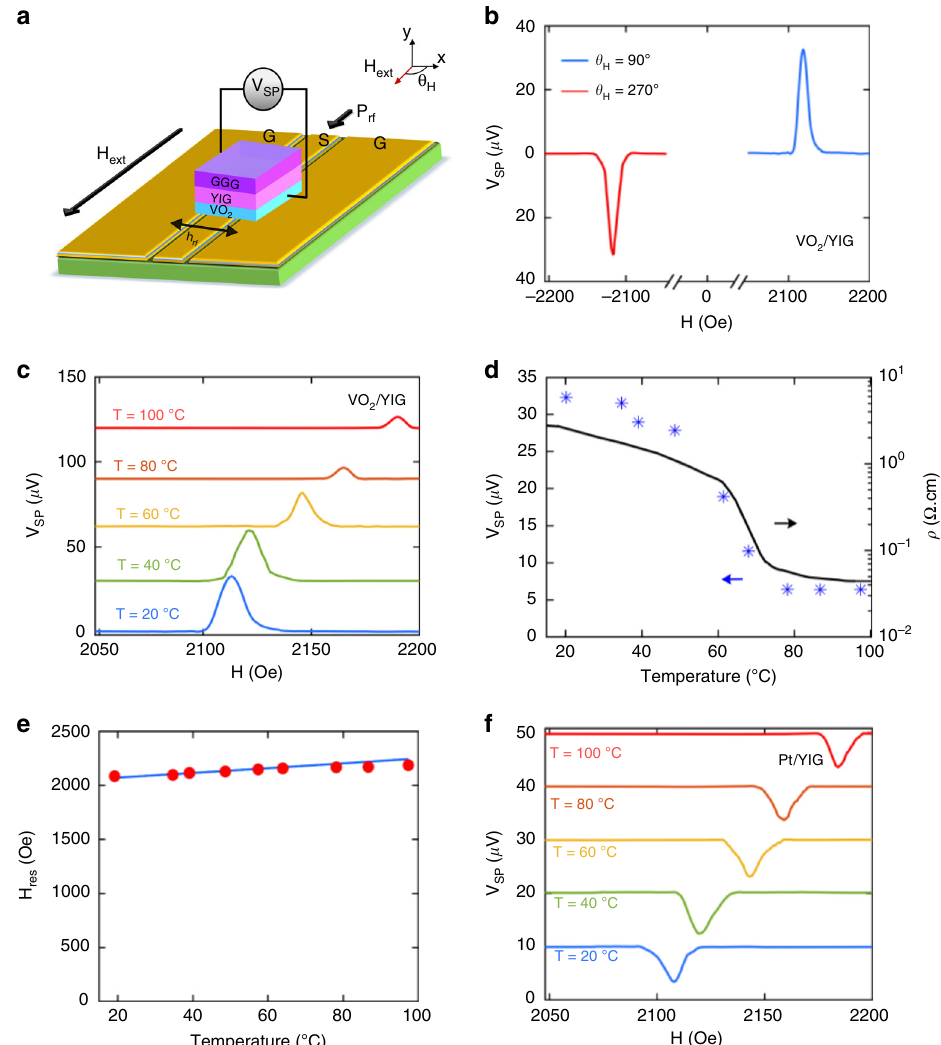
Fig. 2 Schematic illustration of the spin pumping measurement and results. a Schematic of experimental setup for ISHE voltage measurements. b V SP vs . H μ m) bilayer at θ = 90° (blue) and 270° (red) at T = 20 °C. c V μ m) across the ext spectra of VO 2 (68 nm)/YIG (3 H SP spectra of VO 2 (68 nm)/YIG(3 transition; the plots for different temperatures are shifted upwards by 30 μ V for clarity. Temperature dependence of d V SP (stars) and resistivity (line) of theVO 2 (68 nm)/YIG(3 μ m) sample ( e ) Resonant fi eld from experiment (red) and calculated from Kittel ’ s formula (blue) at 8 GHz. (f) V SP vs. H ext for Pt(6 nm)/YIG bilayers sample at different temperatures; plots for different temperatures are shifted by 10 μ V for clarity.